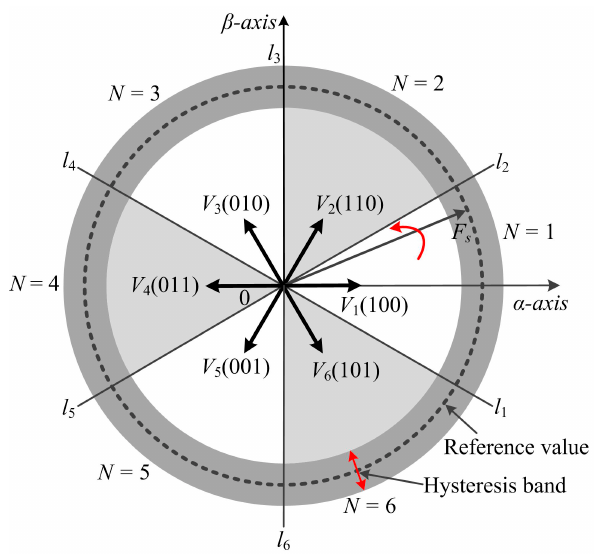
Figure 1. Active vectors in direct torque control (DTC) system.